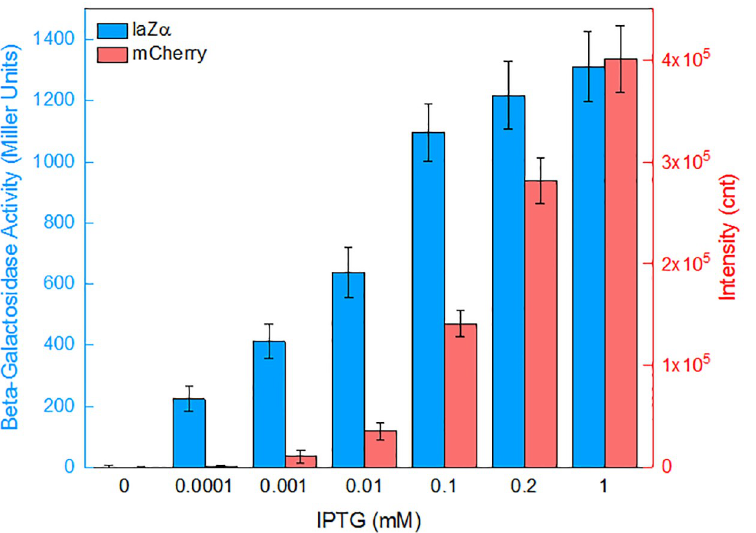
Fig 3. Response of Top10/pPlac-RFP-lacZ α to different concentrations of IPTG. Recombinant E . coli was induced with 0–1 mM IPTG at 37 ˚C for 6 h. Then, the β -galactosidase activity and mCherry fluorescent signal of the induced cultures were